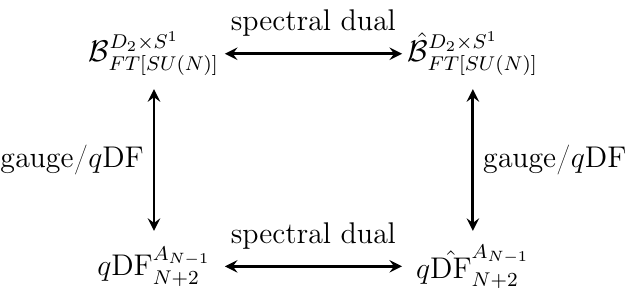
Figure 1 . Duality web I represents the relation between 3 d FT [SU( N )] quiver gauge theories and DF representations of the N + 2-point A N (cid:0) 1 q -Toda conformal blocks with N degenerate primaries. 3 d mirror symmetry of the gauge theories upstairs corresponds to the spectral duality of the CFTs